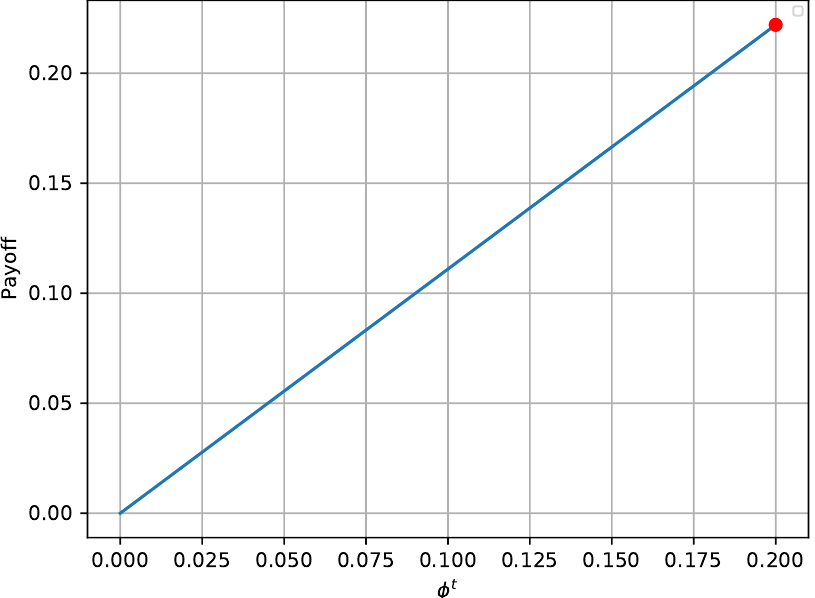
Figure 5. Attacker’s payoff for different strategies in a single turn of the repeated